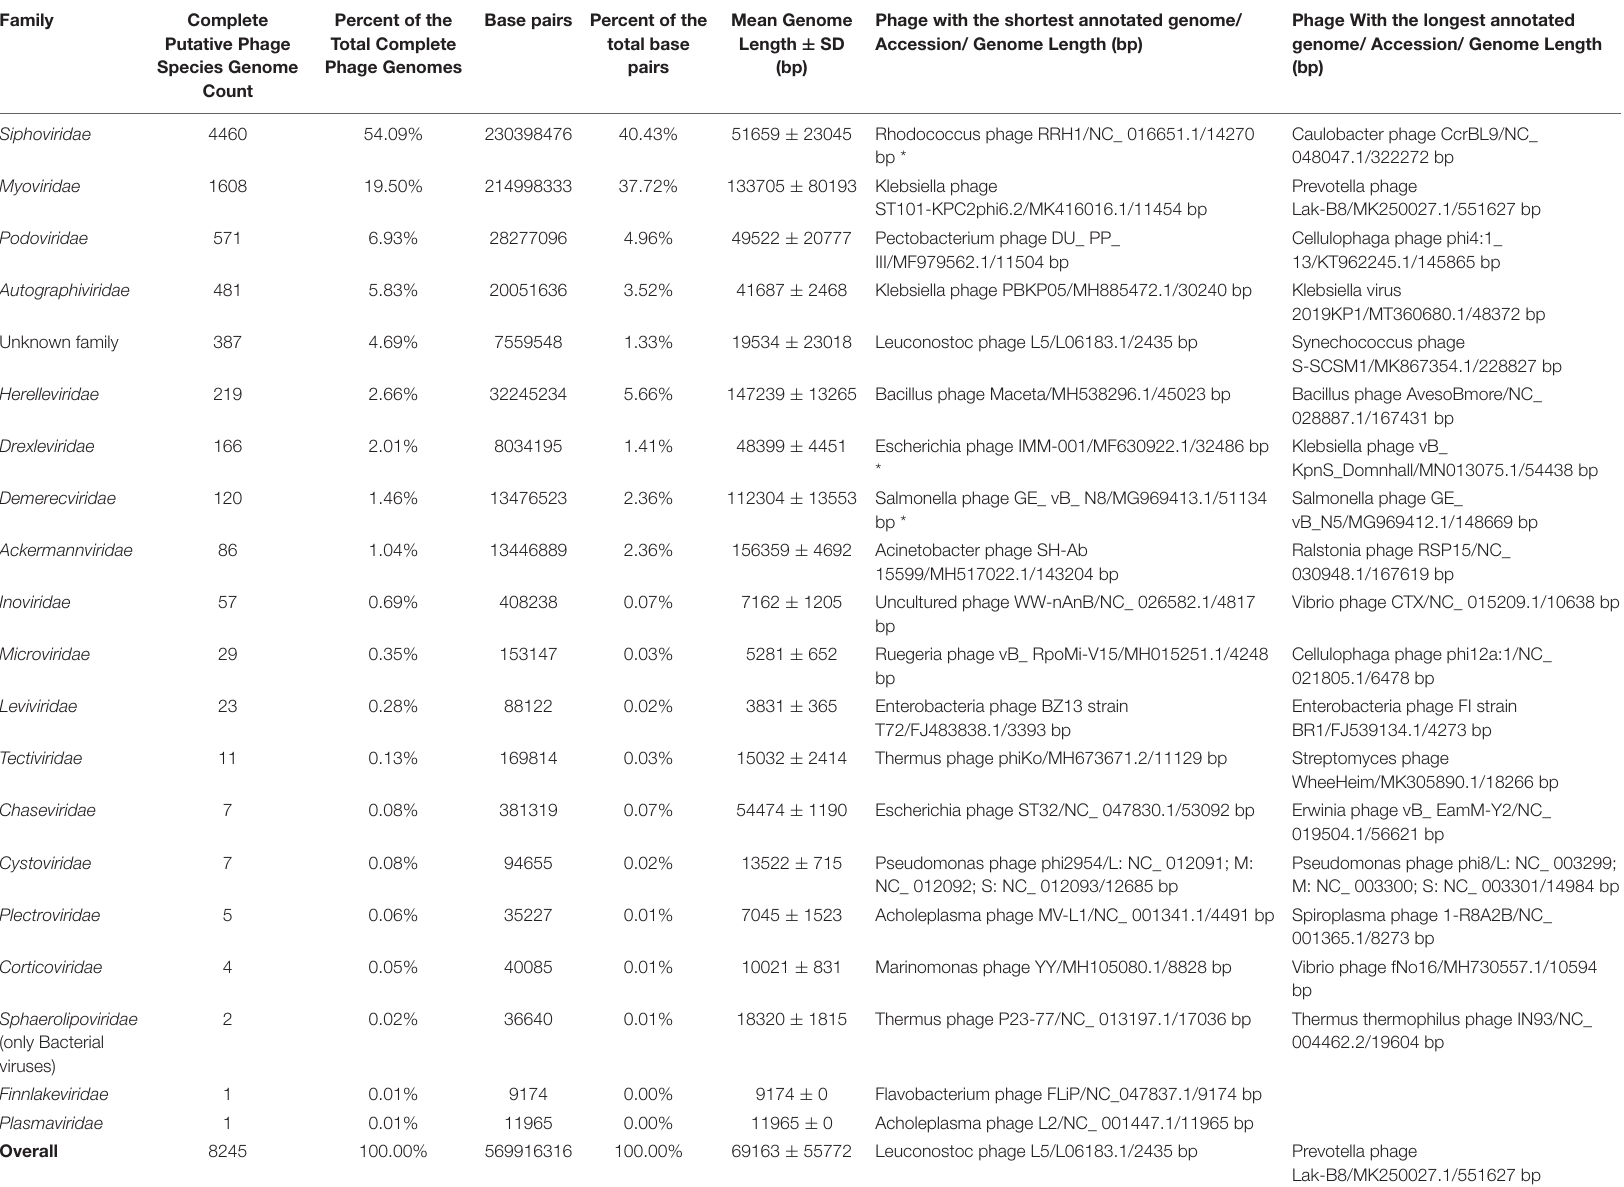
TABLE 1 | Overview of completely sequenced phage genomes. Asterix near entry in the column representing the shortest genome of a phage of a given family indicates the shortest plausible entry and ignores ambiguous entries labeled as “complete genome.”